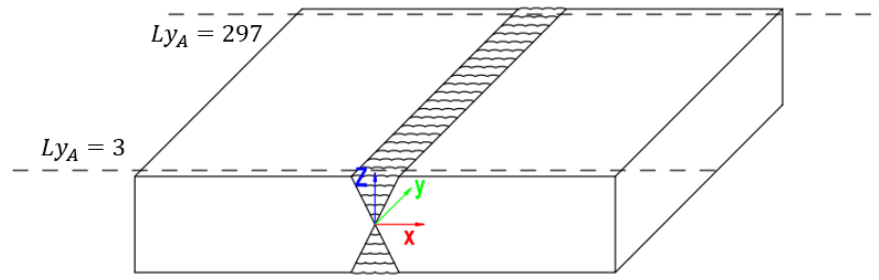
The paths L yA = 297 and L yA = 3 on surface A of the specimen through the weld ends are two transverse paths symmetrical about the center of the weld seam, as shown in Figure 23. Similar to Section 4.1.2, for simplification while not greatly deviating from the actual situation, in the actual stress measurement, only the stress value on the right side of the transverse centerline of the weld seam was measured, and the residual stress value on the left side of the weld seam was estimated assuming the symmetrical distribution of the residual stress.